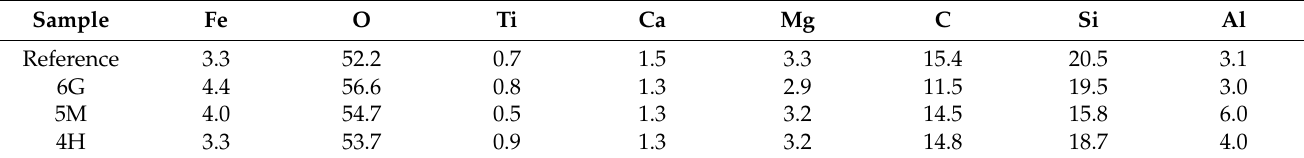
Table 6. Surface atomic concentrations calculated from the wide scan XPS spectra (in